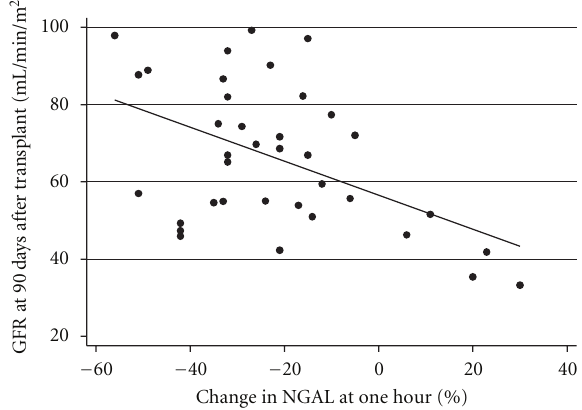
Figure 4: Scatter Plot of percentage change in NGAL at one hour against GFR at 90 days after transplant. Dots represent data points. Solid line represents linear line of best